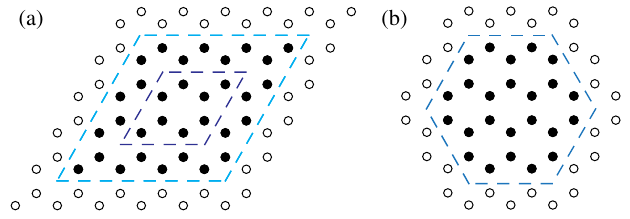
FIG. 5. Three samples marked by dashed lines are used in numerical calculations: (a) 8-site and 32-site samples; (b) 24-site sample. Periodic boundary conditions are applied for each of